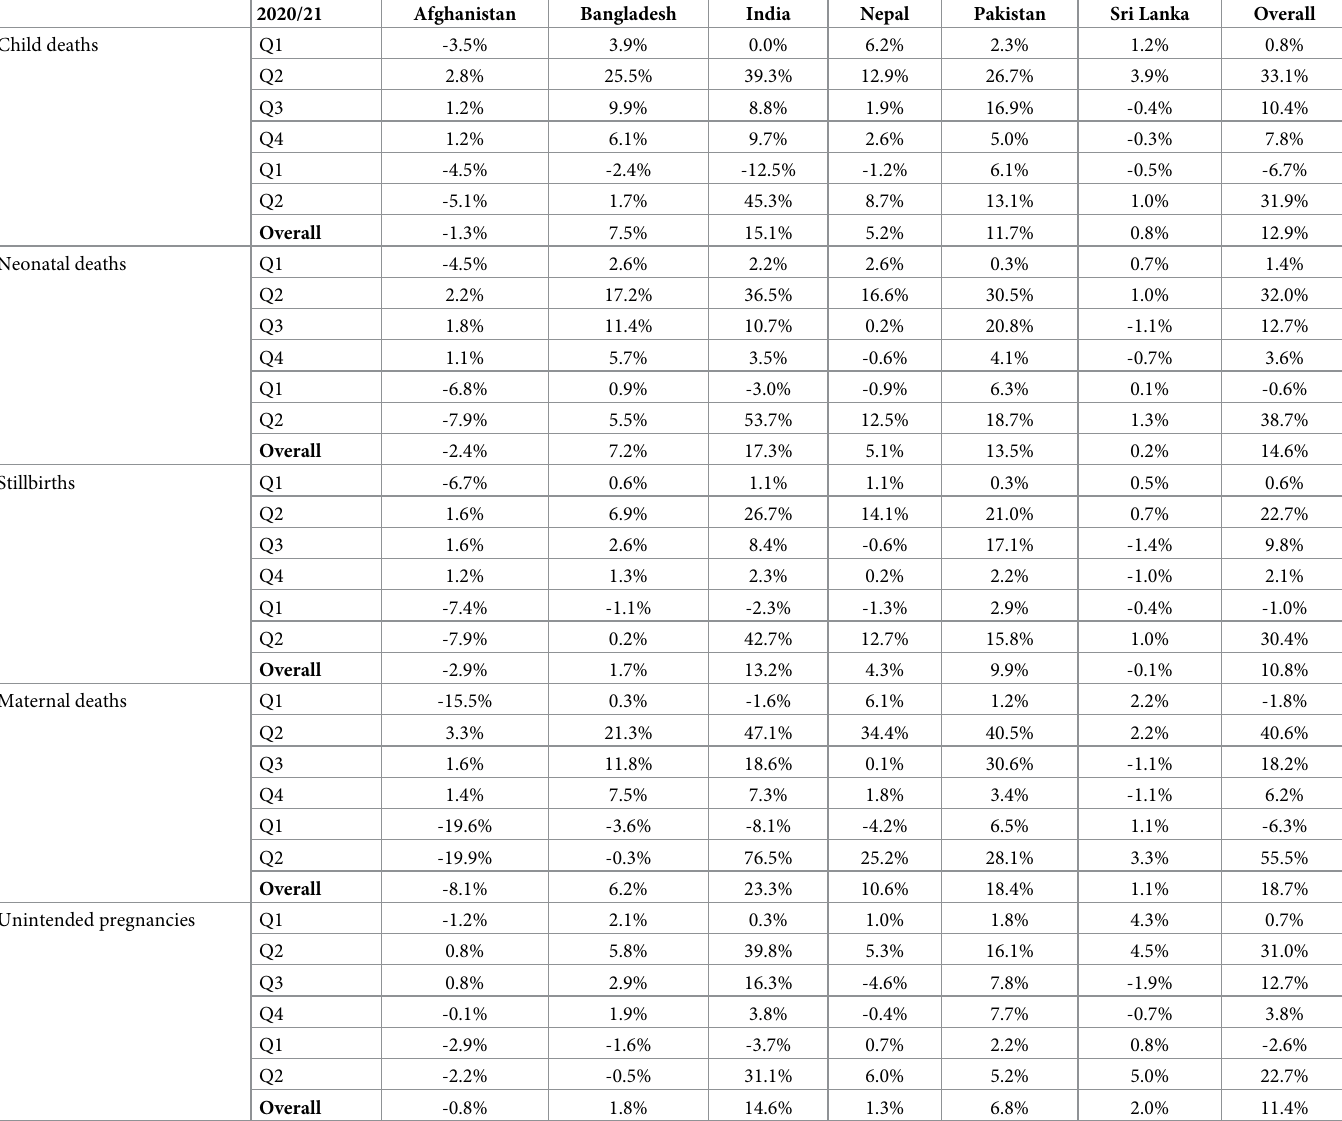
Table 2. Estimated increase in deaths and unintended pregnancies by country, in South Asia, Jan 2020 to Jun 2021.